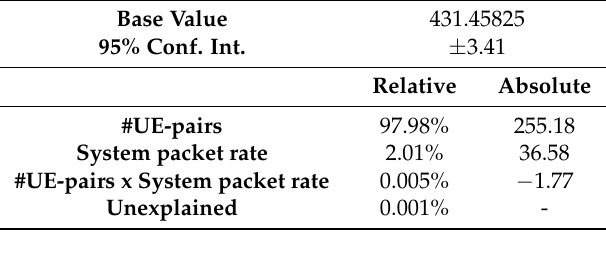
Table 3. Factorial analysis for execution time.